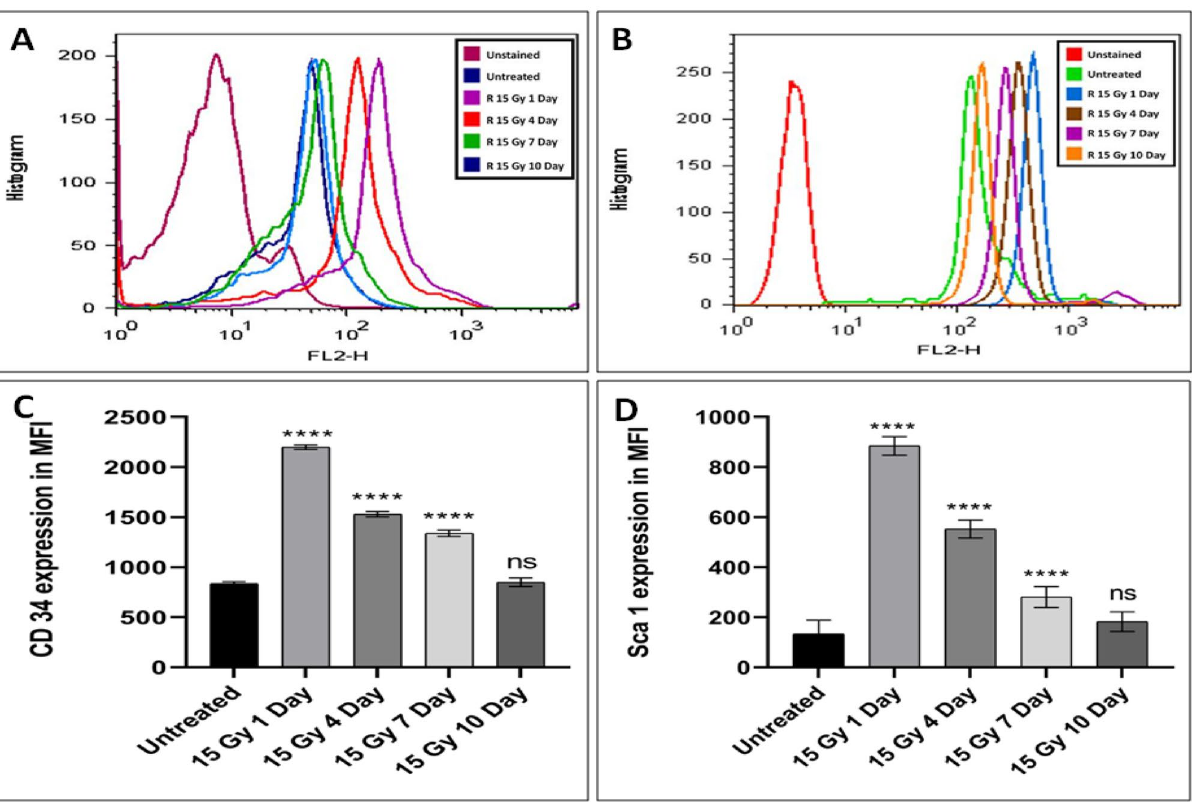
Figure 6. Hematopoietic stem cell marker expression in mice bone marrow cells after 15 Gy localized radiation exposure. ( A , B ) represents the flow cytometry data in the form of histograms of CD 34 and Sca 1 respectively. ( C ) Bars indicate CD 34 expression in mouse bone marrow at various time intervals. ( D ) Bars indicate Sca 1 expression in mouse bone marrow at various time intervals. The results were analyzed at BD-FACS LSR II using BD FACSDiva V7 program. The bars represent the mean ± SD of 6 animals. A value of p < 0.05 is considered statistically significant *p < 0.05, **p < 0.01, ***p < 0.001, ****p < 0.0001 , ns = not significant (p >